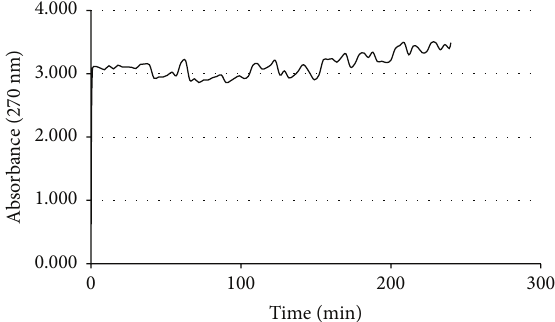
Figure 4: UV-visible spectra of Ag nanoparticles as function of time at room temperature and pH 6.